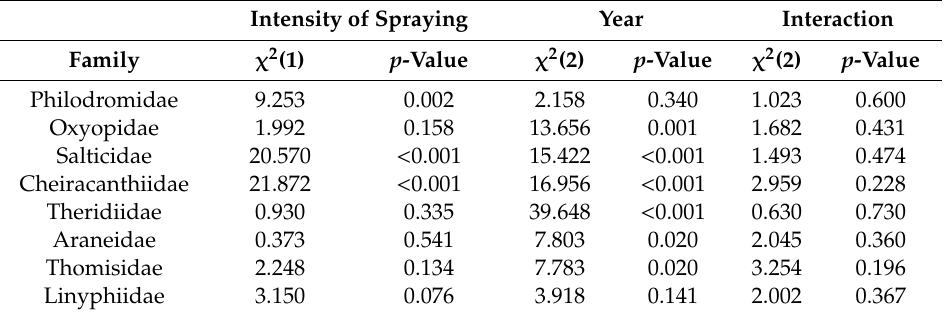
Table 2. Statistics of generalized linear mixed models (GLMM) for the effect of intensity of spraying, year, and their interaction on the abundance of the main spider families. χ 2 = Chi square values (degrees of freedom within brackets).